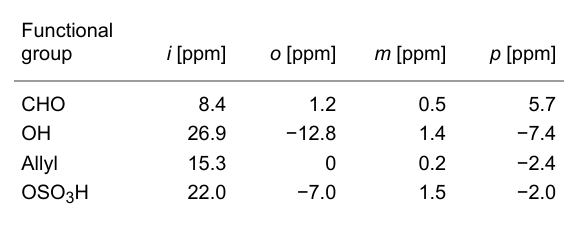
connected to hydroxy groups rather than sulfate ester groups